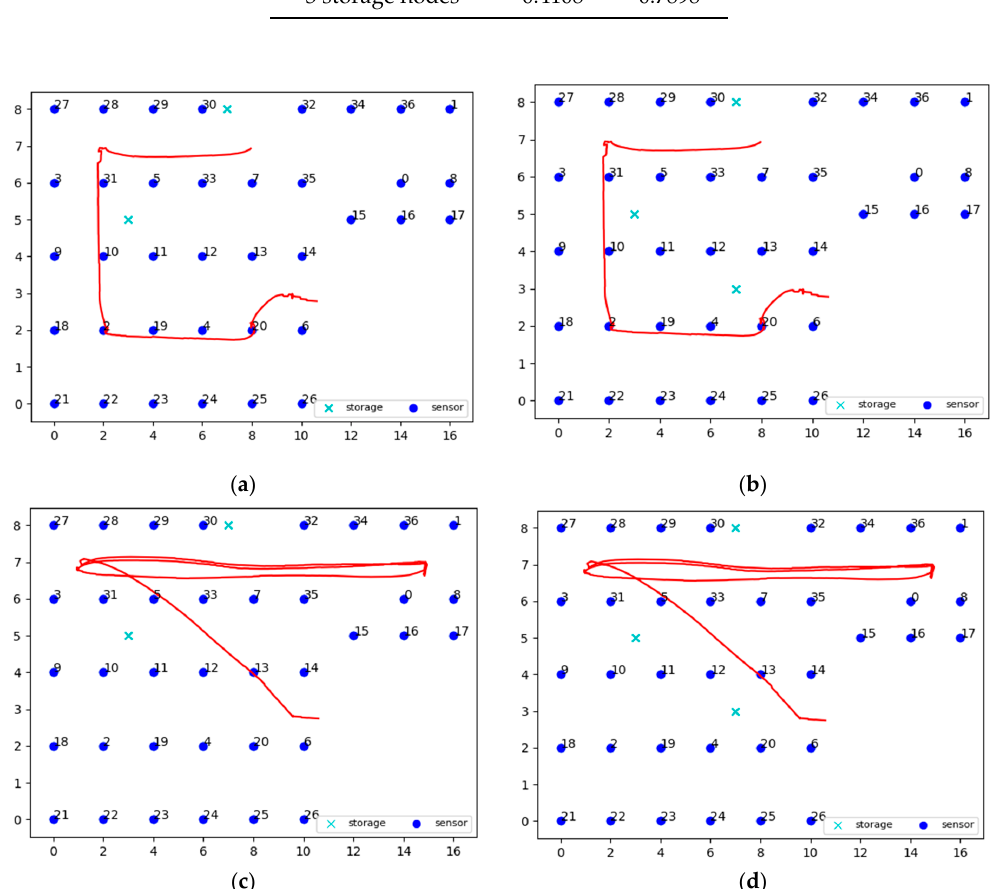
Figure 11. Trajectories over the topology of 37 nodes with r d = 1.5 and α = 2 for ( a ) 2 servers and square_1 trajectory, ( b ) 3 servers and square 1 trajectory, ( c ) 2 servers and h_line_2 trajectory, ( d ) 3 servers and h_line_2 trajectory.